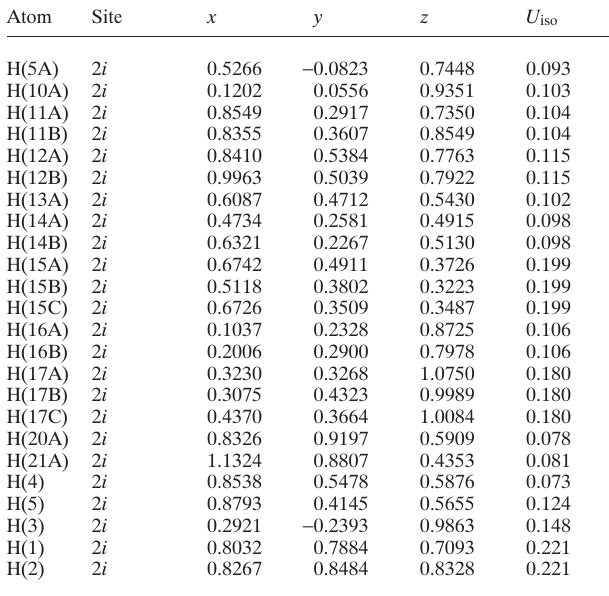
Table 2. Atomic coordinates and displacement parameters (in Å 2 )